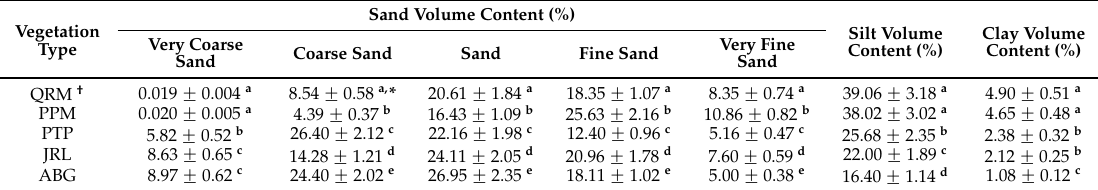
Table 2. Soil particles-size distribution (PSD) under the different vegetation types in the study area. Vegetation Type